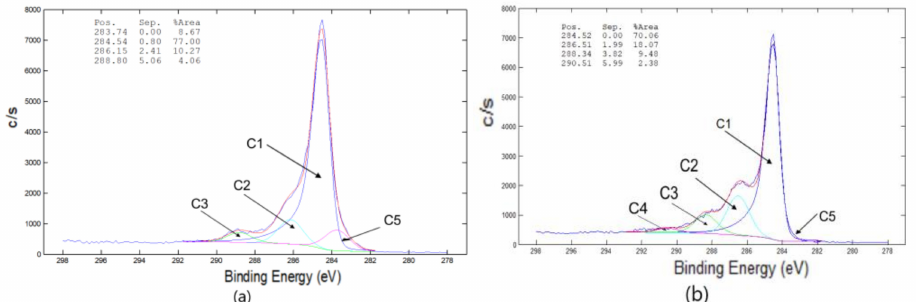
Figure 2. X-ray photoelectron spectroscopy (XPS) on CNT / PU and CNT / PU KMnO 4 . ( a ) Curve fitting of the C 1s carbon spectrum of the MWCNTs (pure). ( b ) Curve fitting of the C 1s carbon spectrum of MWCNTs (KMnO 4